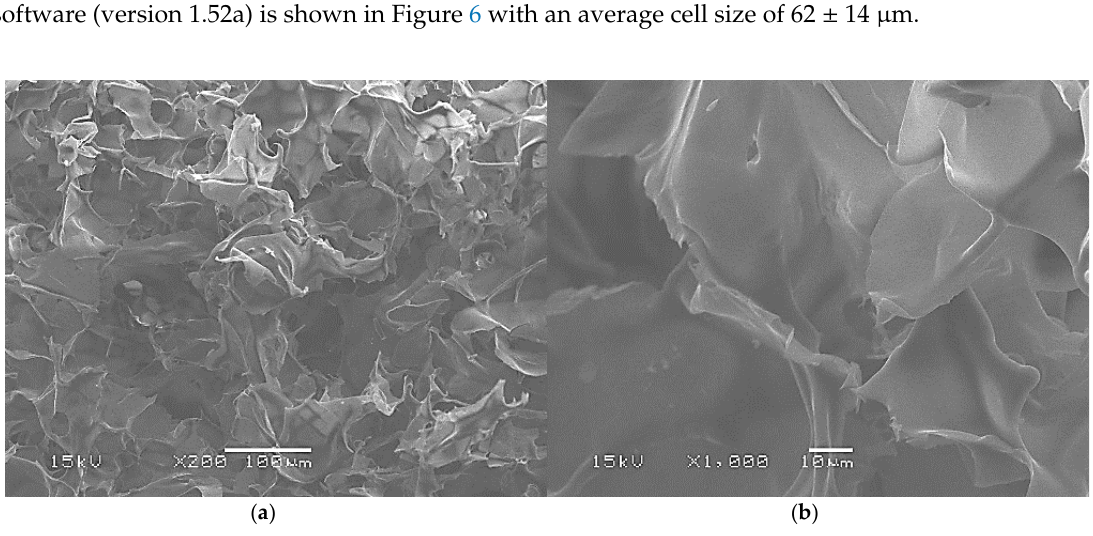
0.10.15 Figure 6. Cell size frequency distribution of dry lyophilized starch raw material. After plasticization of starch, the cell structure observed in Figure 5 disappears, leaving a corrugated sheet structure as shown in Figure 7. This corrugated sheet structure is characteristic of a 0 0.05